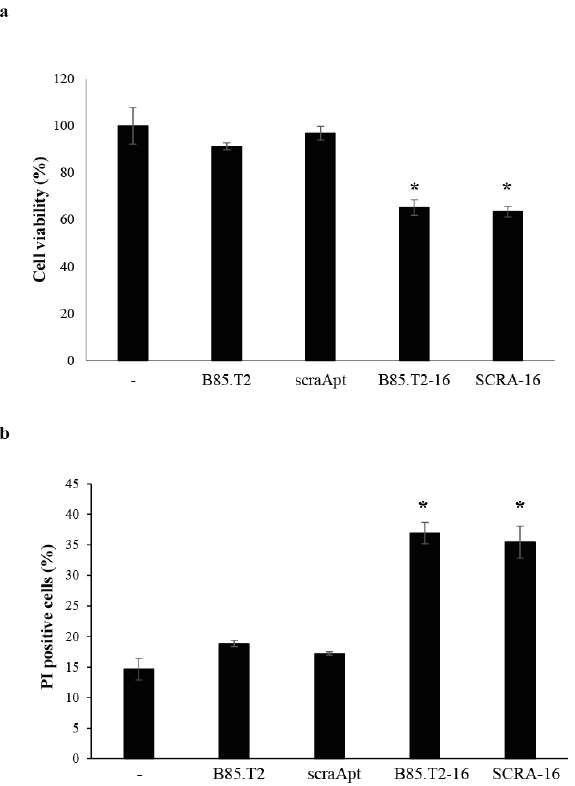
Figure 6. B85.T2-16 chimera functional activity. ( a ) MEC-1 cells were treated with indicated molecules (400 nM) for 5 days. Cell viability was monitored by MTT assay, and results are expressed as percent compared to untreated cells (-). Error bars show the mean ± SD values on technical triplicates. ( b ) MEC-1 cells were treated with indicated molecules (400 nM) for 5 days and then recovered and incubated with 40 µ g/mL PI. The percentage of PI-positive cells was analysed at FACS and reported in the graph. Error bars show the mean ± SD values on experimental duplicates. Statistics were calculated using Student’s t test, * p < 0.05.